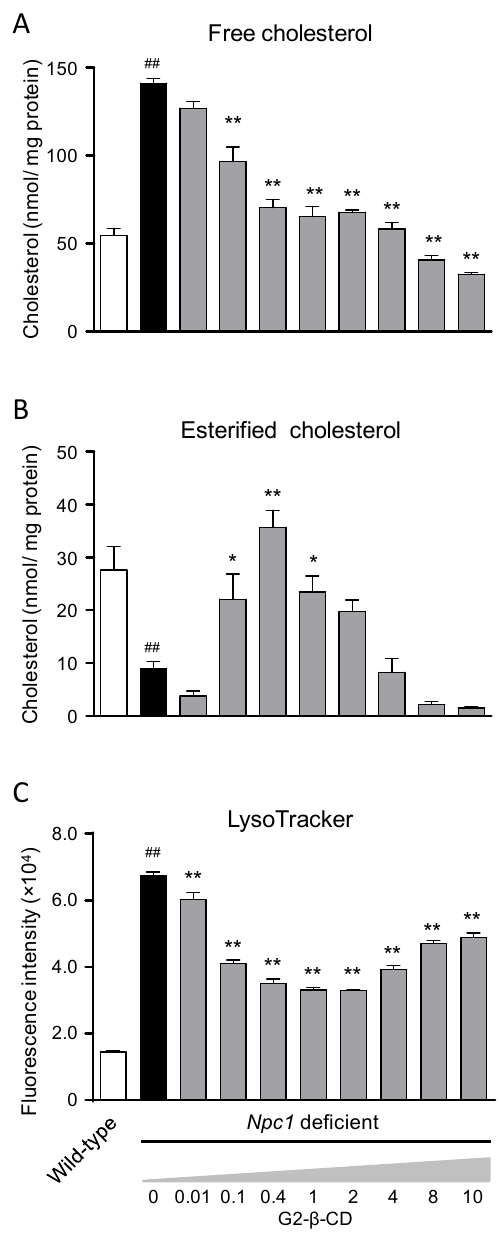
Figure 5. Concentration-dependent effects of G2- β -CD on intracellular cholesterol trafficking and lysosome volume in Npc1 deficient cells. Intracellular FC ( A ) and EC ( B ) levels were measured 24 h after G2- β -CD treatment of Npc1 deficient cells. The fluorescence intensity of LysoTracker ® was determined by flow cytometry 24 h after G2- β -CD treatment ( C ). Each bar represents the mean ± S.E.M. ( n = 6 for FC and EC, and n = 3 for LysoTracker ® experiments). ## P < 0.01 compared with the Wild-type group. * P < 0.05, ** P < 0.01 compared with the 0 mM group. 2.4. Hepatoprotective Effects of Subcutaneous G2- β -CD Treatment in Npc1 Deficient Mice